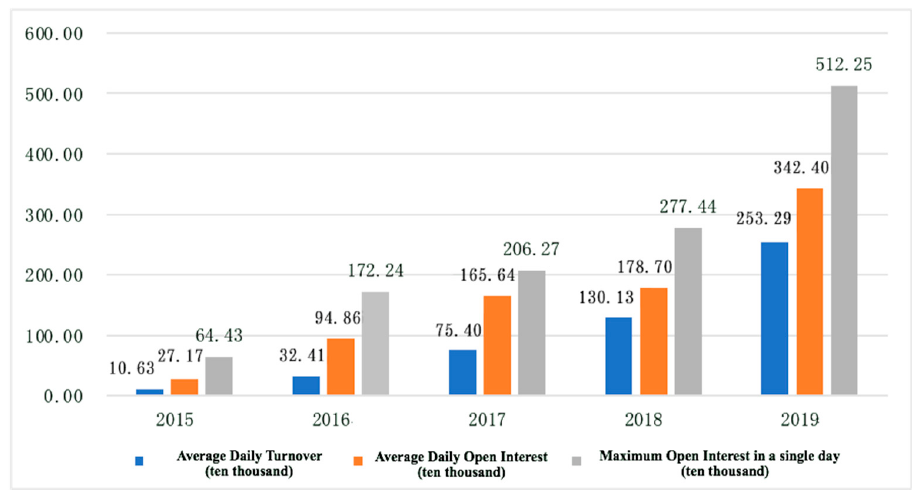
Figure 1. Development of SSE 50ETF index options.